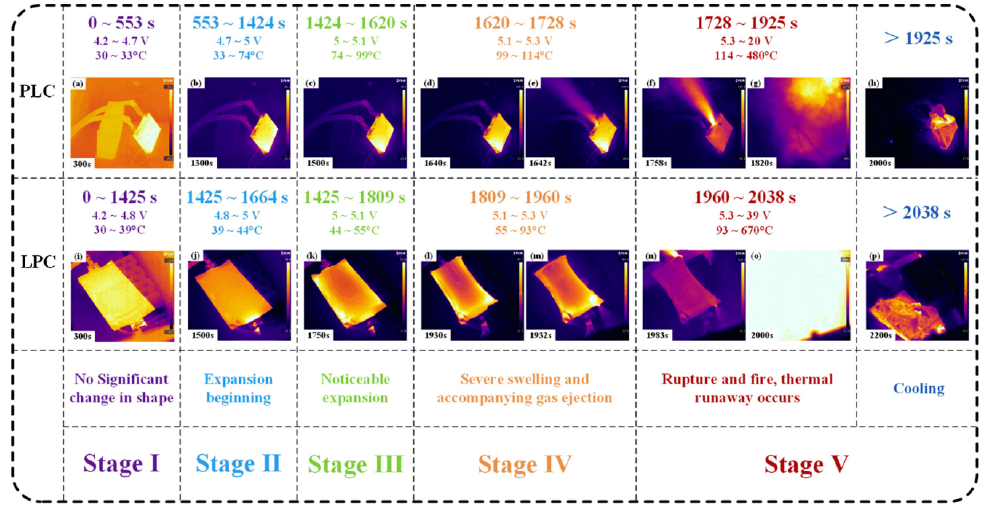
Figure 9. Thermal infrared images of thermal runaway (TR) behavior of battery cells during 1 C current overcharge: ( a – h ) prismatic cell; ( i – p ) pouch cell [78].